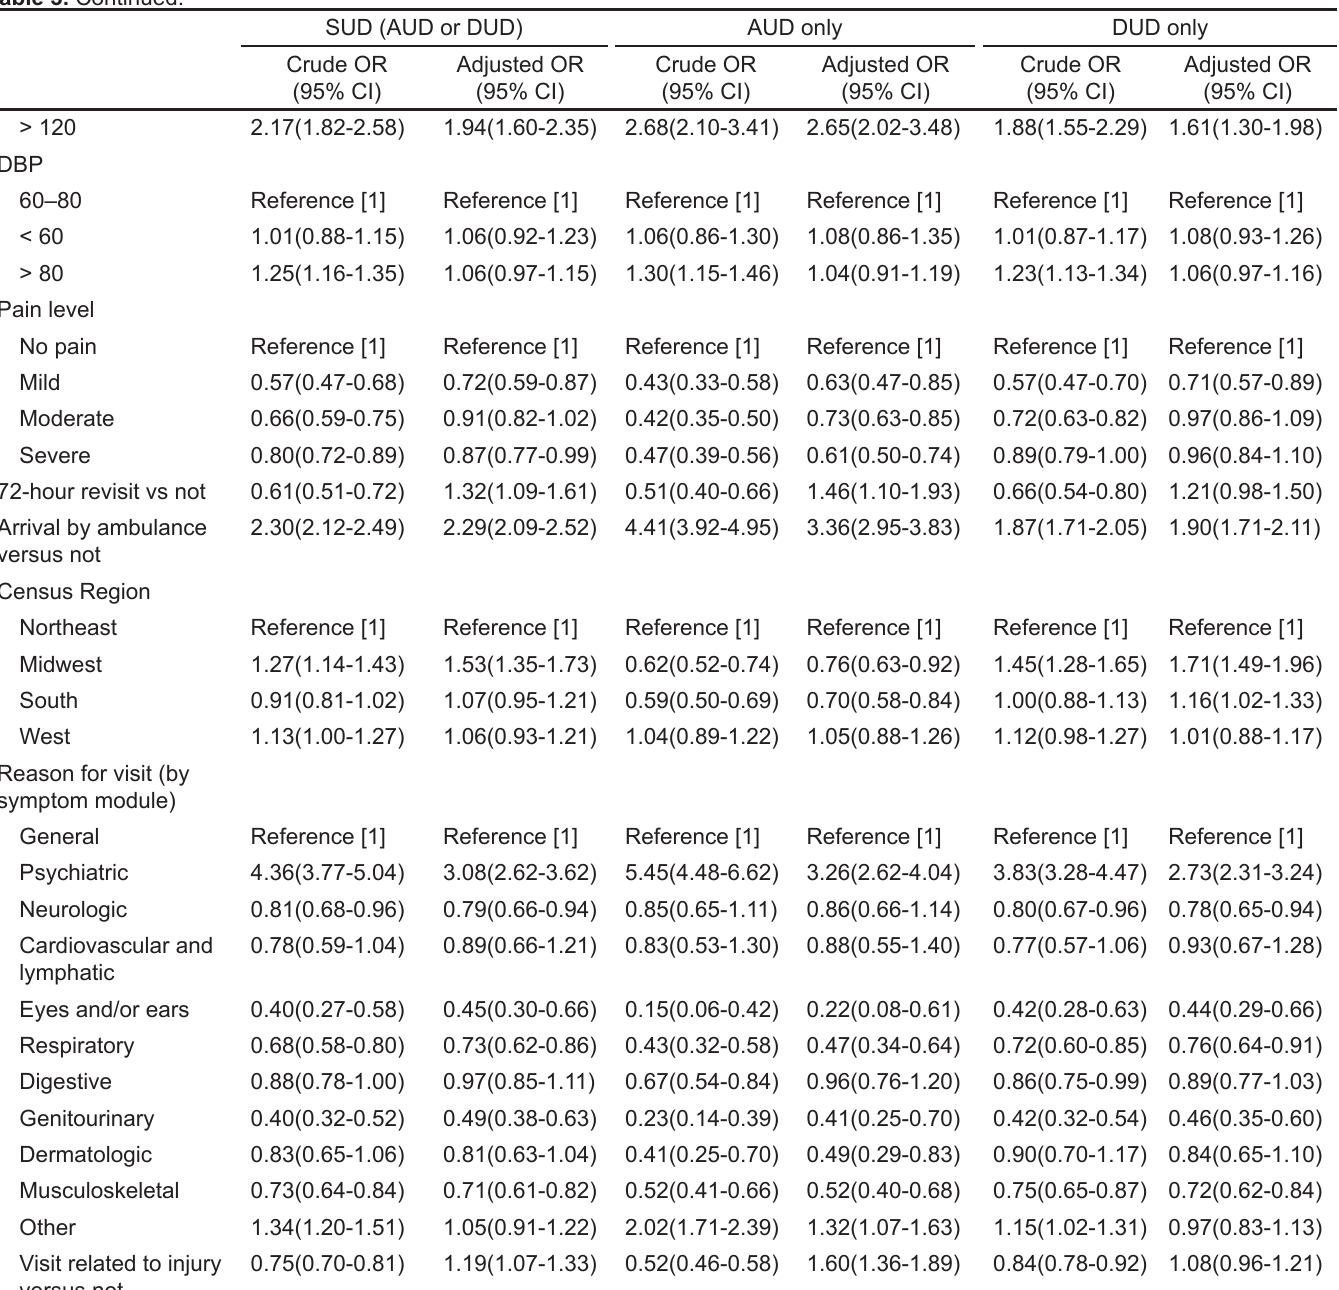
Note: The adjusted odds ratio (OR) was from a logistic regression including all variables in the table. DUD, drug use disorder; SUD, substance use disorder; AUD, alcohol use disorder; CI, confidence interval; OR, odds ratio; DBP, diastolic blood pressure; SBP, systolic blood